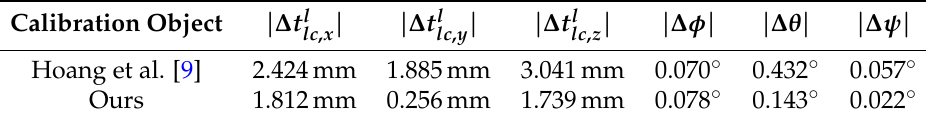
Table 2. Absolute pose error between the laser rangefinder and front-facing camera.